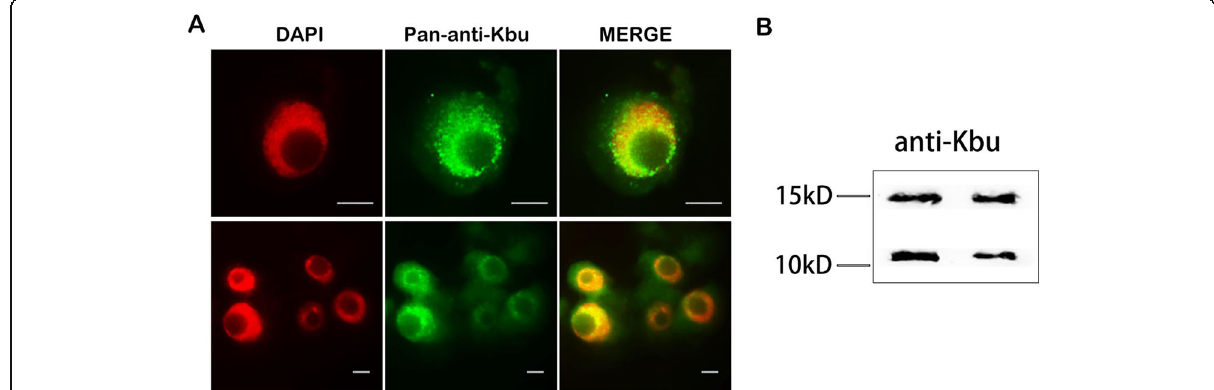
Fig. 1 An overview of Kbu modifications in rice. a lysine butyrylation was detected in the nucleus and cytoplasm of two-week-old rice root cells by immunofluorescence using an anti-Kbu antibody (green), and the nuclei were stained with DAPI (red). Scale bars: 5 μ m. b Western blot analysis of histones in 14-day-old rice seedling leaves with anti-Kbu antibody